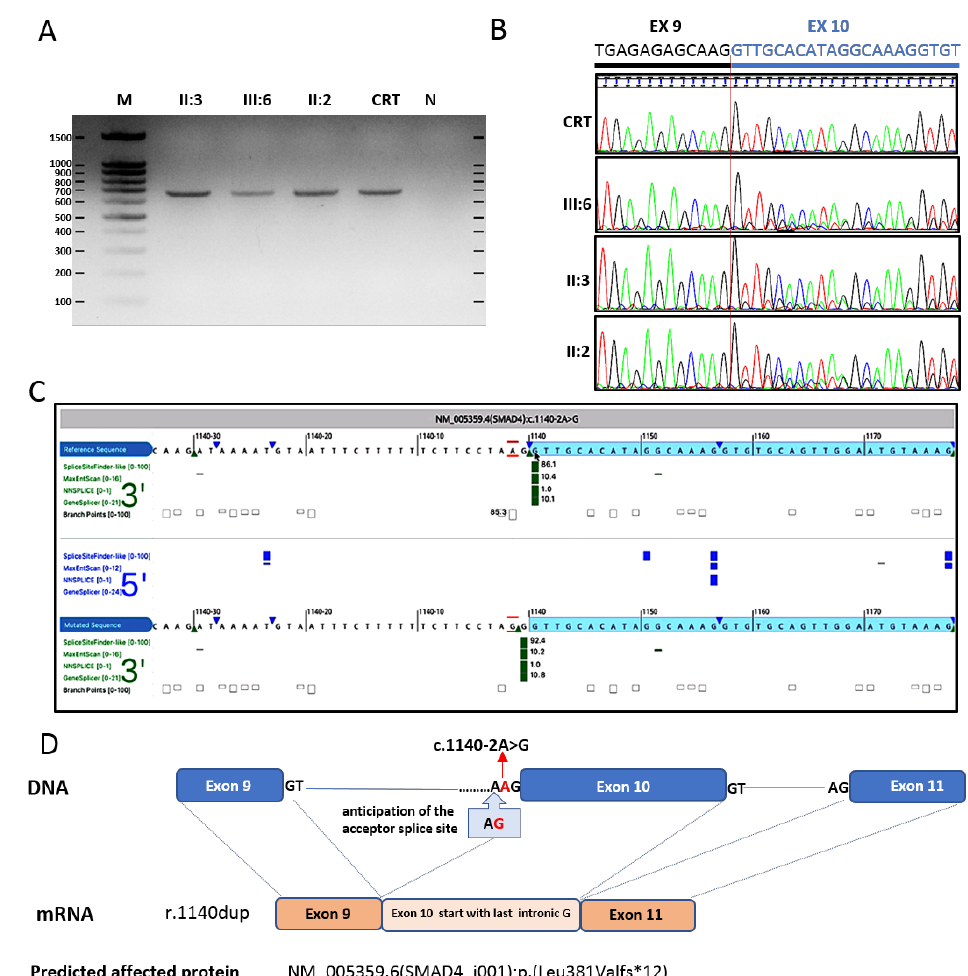
Figure 3. Analysis of the NM_005359.5:c.1140-2A>G acceptor splice variant in SMAD4 gene ( A ) RT- PCR products amplified with primers spanning the junction of exons 6–7 and 10–11 in RNA from leukocytes and separated on 1% agarose gel. M: 100-bp DNA ladder, CRT: normal control, N: PCR control. ( B ) Sanger sequencing of PCR product, indicating displacement of the splice acceptor